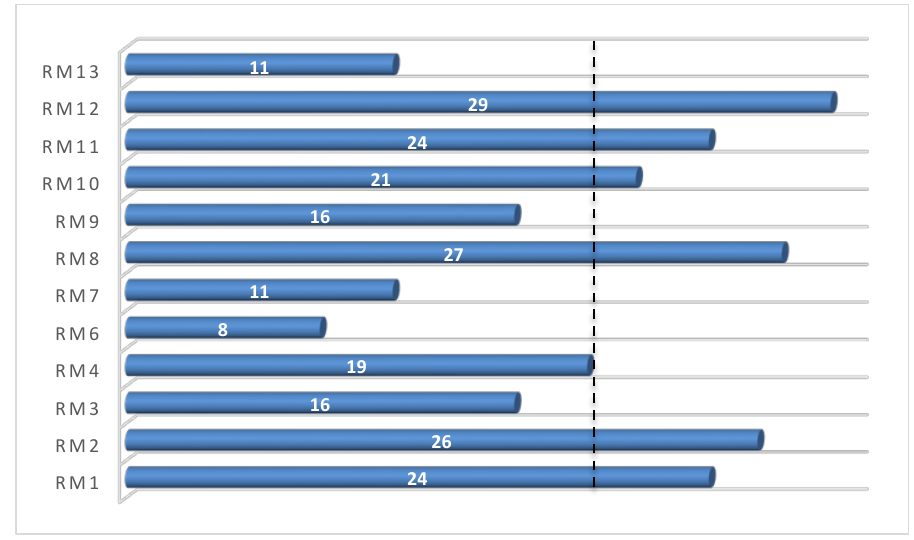
FIGURE 1: Current practices in disclosure on risk management